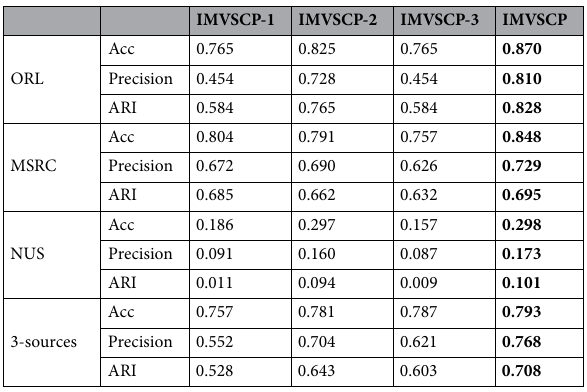
Table 8. The comparison results of IMVSCP, IMVSCP-1, IMVSCP-2 and IMVSCP-3 on ORL, MSRC, NUS and 3-sources datasets. Significant values are in